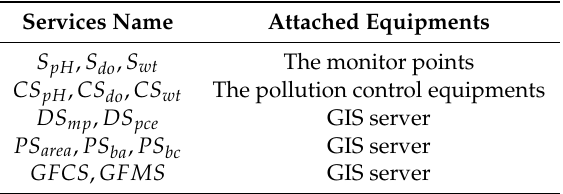
Table 4. Attached equipments of the